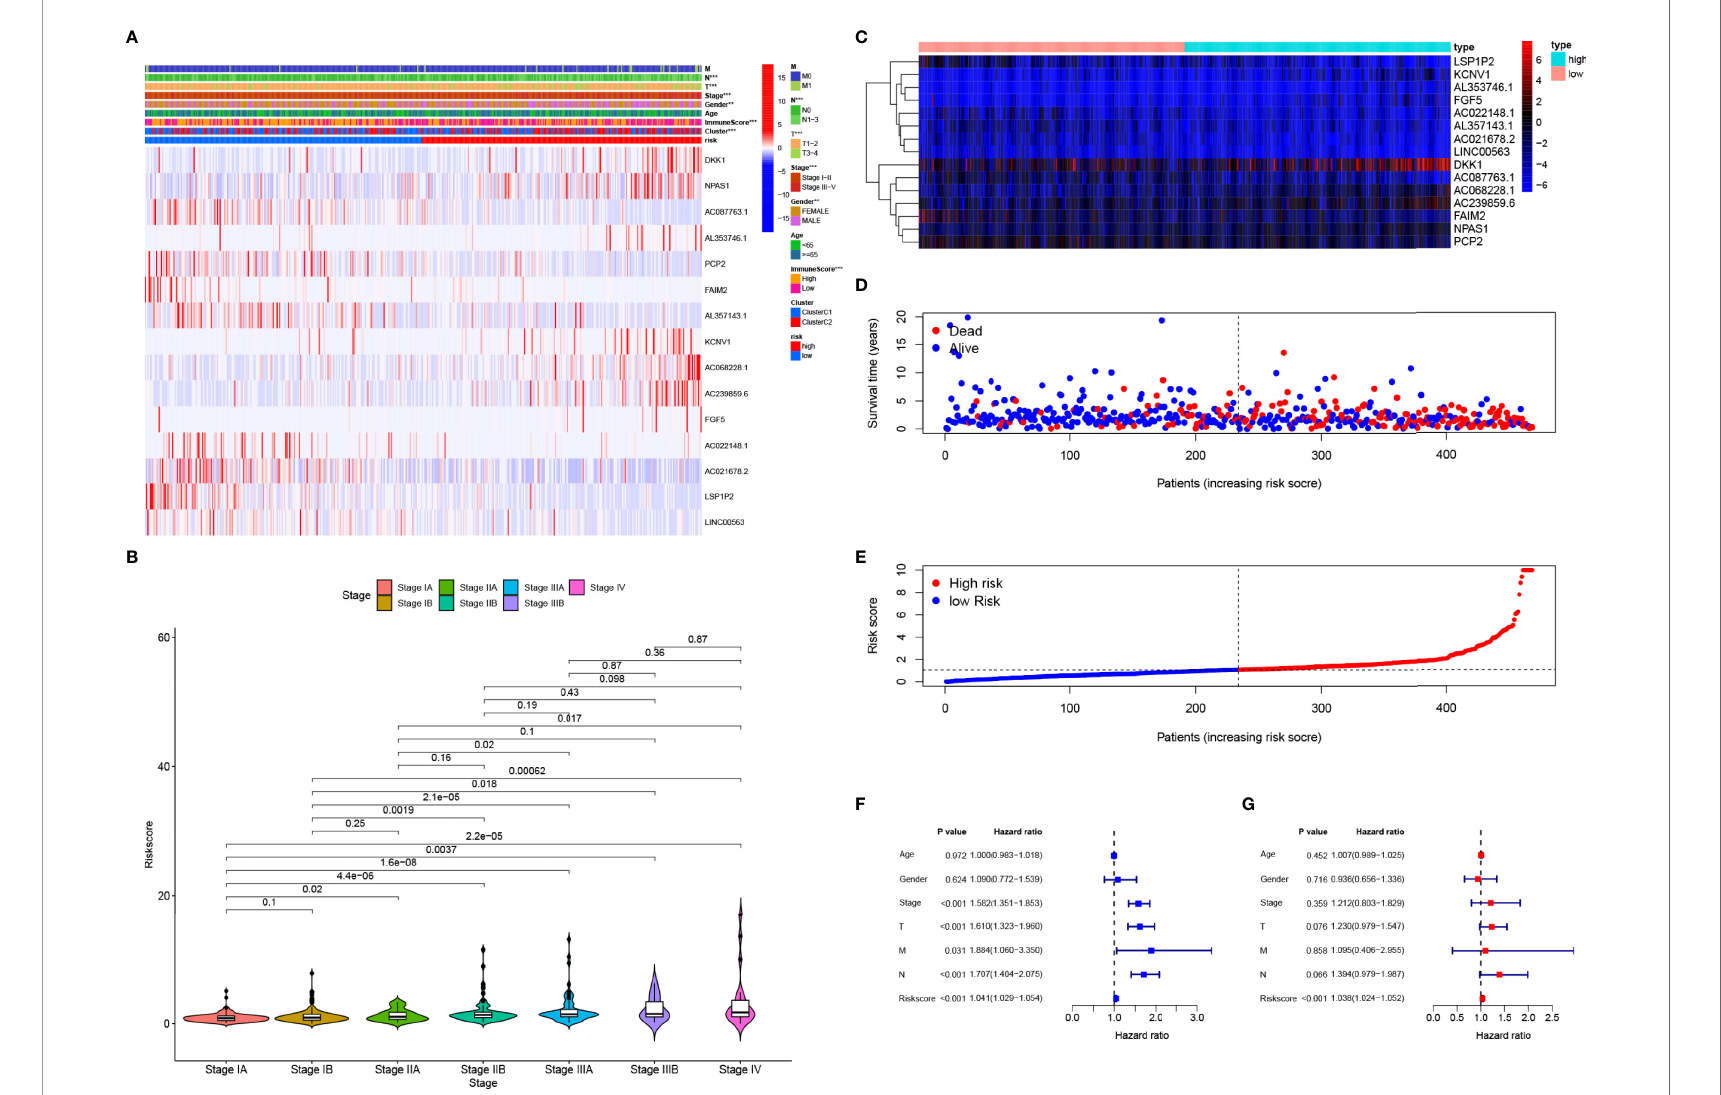
FIGURE 4 | Clinical application of the 15-gene risk signature. (A) Heatmap showing that the TNM stage, immune scores, NMF subgroup, gender, T stage, and N stage were signi fi cantly associated with risk scores, and the expression levels of the 15 DEGs were different between the high- and low-risk groups. (B) Violin plots showing the relationship between the risk score and TNM stage. (C – E) Heatmap of the mRNA expression of the risk signature (C) and risk curves in the TCGA-LUAD cohort (D, E) . (F, G) , Univariate (F) and multivariate (G) Cox regression analyses suggested that the 15-gene risk signature was the independent prognostic factor in the TCGA-LUAD cohort. ROC, receiver operating characteristic curve; LUAD, lung adenocarcinoma; DCA, decision curve analysis. * represent P ≤ 0.05, ** represent P ≤ 0.01, *** represent P ≤ 0.001, and **** represent P ≤